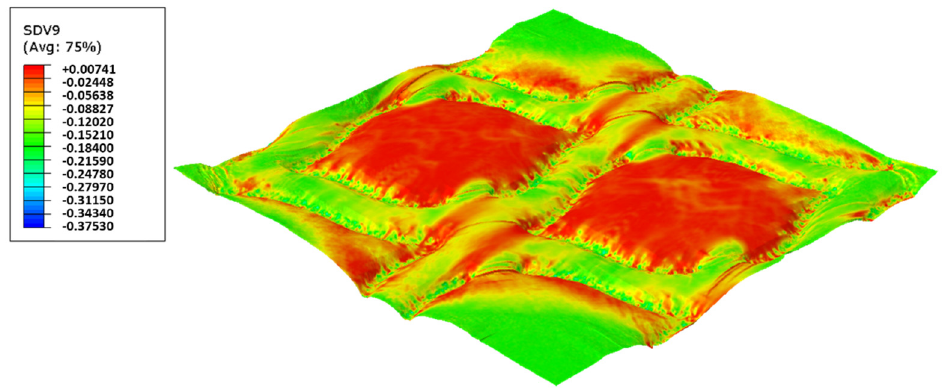
Figure 27. Deco die 48_75 Sh-A (NR BG/CR PR), Plastic field.